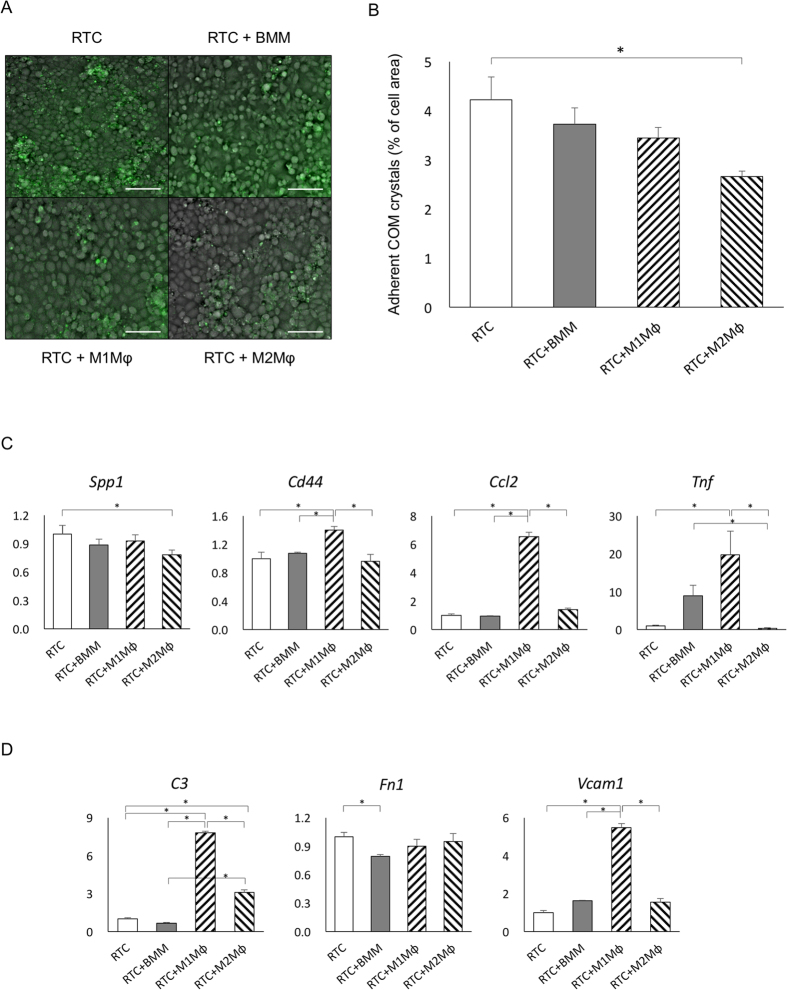
Analysis of the role of M1 and M2 macrophages in the adherence of calcium oxalate (CaOx) monohydrate (COM) crystals on renal tubular cells in vitro.(A) Representative fluorescent micrographs show the attachment of fluorescein isothiocyanate (FITC) -labeled COM crystals on renal tubular cells. Scale bar = 50 μm. (B) Area occupied by crystalline material was measured and expressed as percent of image area. Asterisk indicates p < 0.05. (C) Expression of crystal- and inflammation-related genes. (D) Expression of adherence-related genes. The expression of each gene was determined by quantitative reverse transcription polymerase chain reaction (qRT-PCR) using TaqMan assays. Control values are the average of the data for renal tubular cells (RTCs). Data are presented as means ± standard errors. N = 6 for each group. Asterisk indicates significant differences at p < 0.05. Spp1, secreted phosphoprotein 1; Ccl2, chemokine (C-C motif) ligand 2; Tnf, tumor necrosis factor; Fn1, fibronectin 1; Vcam1, vascular cell adhesion molecule 1.